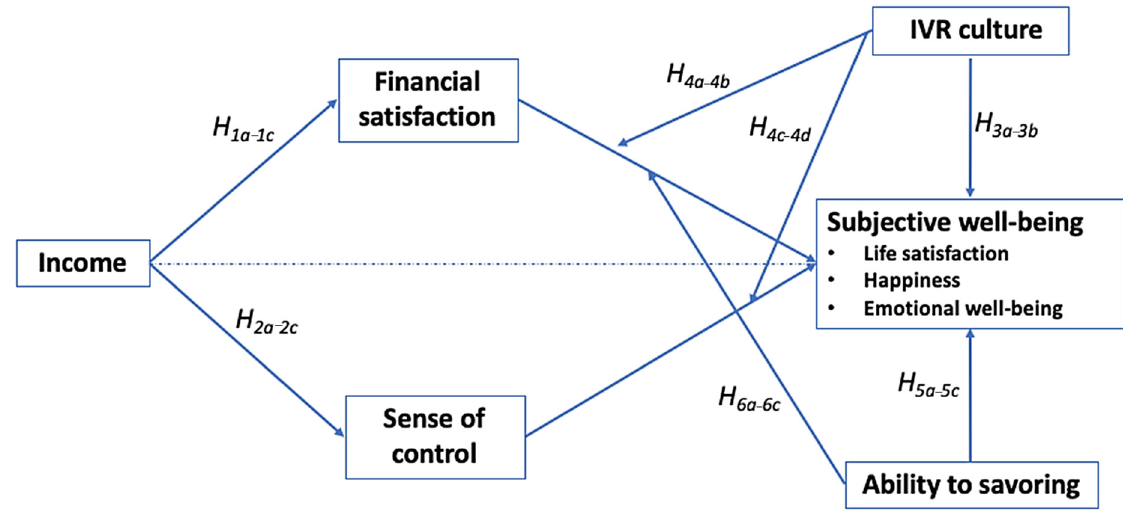
Figure 1. Conceptual model.